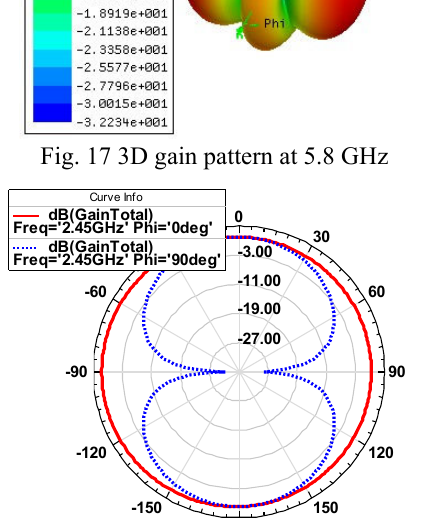
Fig. 18. 2D radiation patterns at 2.45 GHz